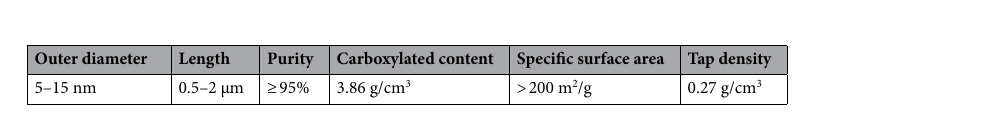
Table 2. Main parameters of carbon